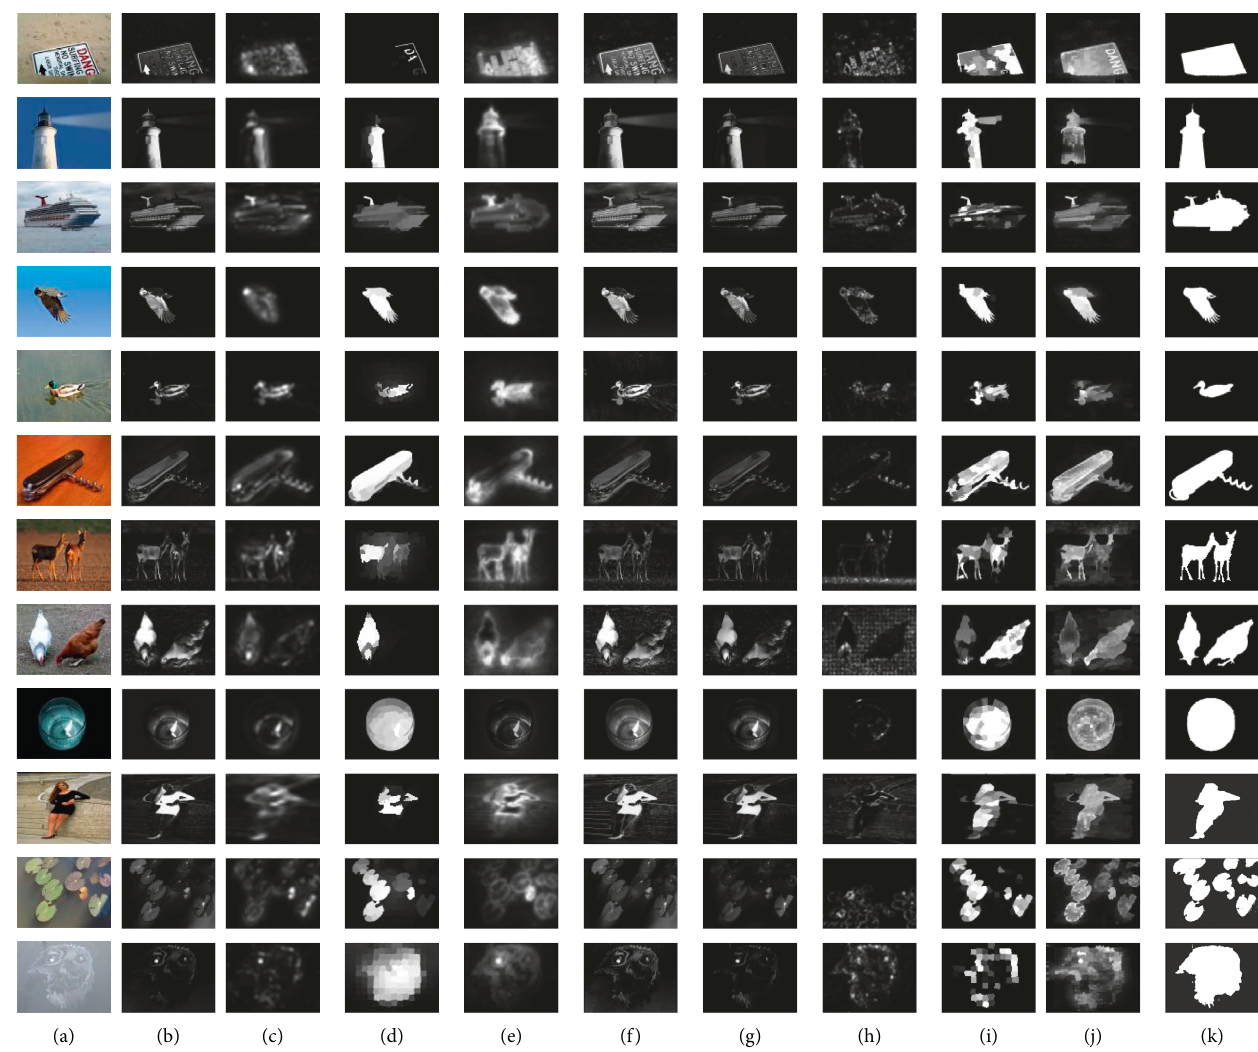
Figure 5: Saliency detection using different algorithms over six datasets. (a) Original image; (b) FT; (c) IT; (d) GBMR; (e) CA; (f) LC; (g) MSS; (h) SF; (i) SRFC; (j) ours; and (k) ground